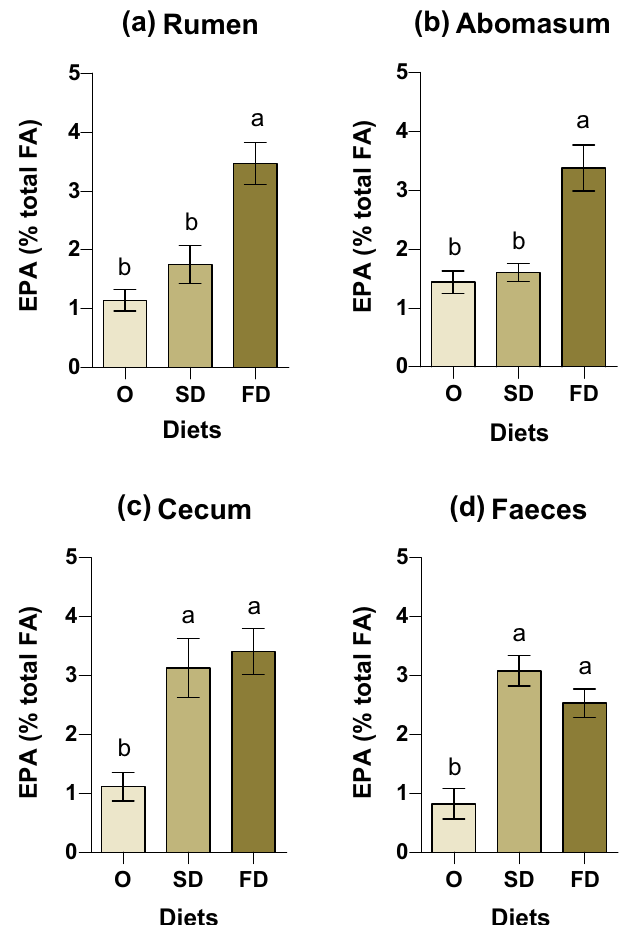
Figure 1. EPA content (% total fatty acids) in the ( a ) rumen content, ( b ) abomasal content, ( c ) cecal content, and ( d ) faeces. Diets are represented as follow: O ( Nannochloropsis sp . oil), SD (spray-dried N. oceanica ) and FD (freeze-dried N. oceanica ). Least square means are presented in each bar with respective standard error of the mean. Different letters (a–c) in each bar indicate significant differences ( P < 0.05) among